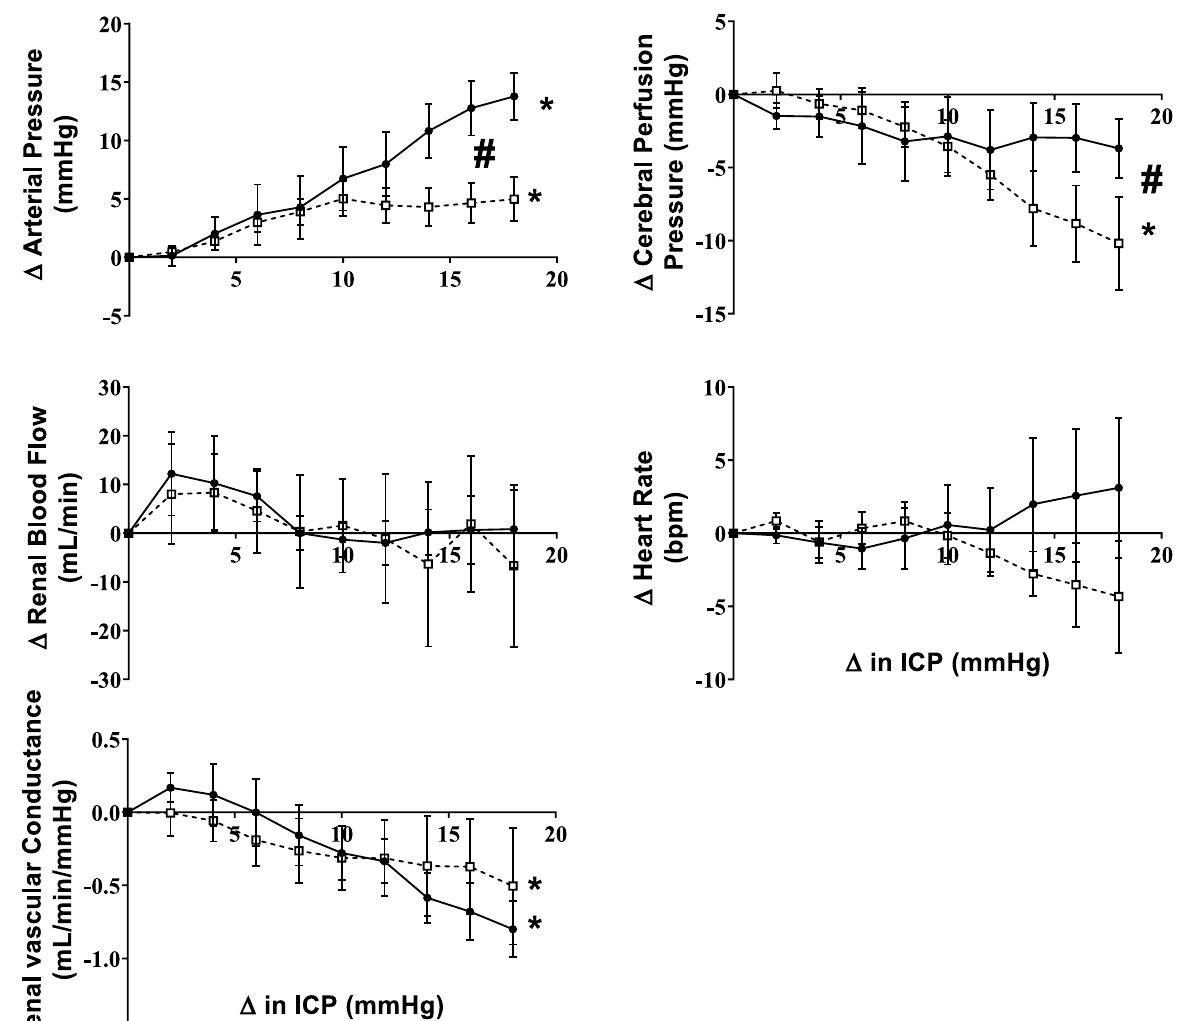
Figure 2. Response of arterial pressure, cerebral perfusion pressure, heart rate, renal blood flow and renal conductance to increased ICP in the normotensive (n = 6) and the hypertensive group (n = 6). All parameters are plotted as an absolute change from baseline. Data are mean ± SEM. *denotes significant effect of ICP change while # denotes significant interactions effect (group vs. ICP change); p <